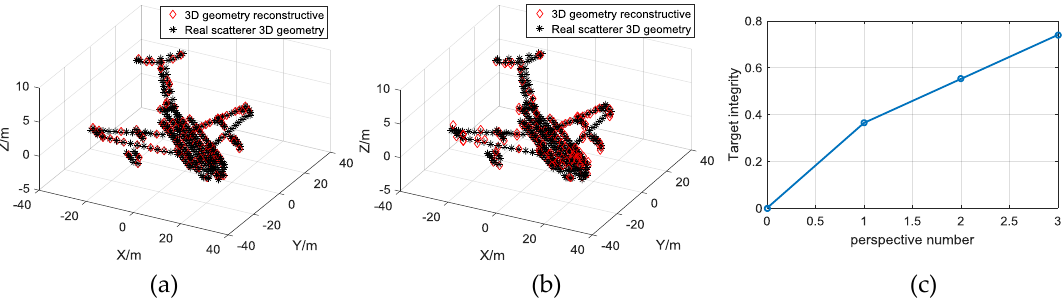
Figure 14. The estimated attitudes of multi-perspective 3D reconstruction from di ff erent conditions. ( a ) The estimated attitudes of multi-perspective when the rotational velocity is 2 degrees per second and noise level is 0.5 times range resolution. ( b ) The estimated attitudes of multi-perspective when the rotational velocity is 10 degrees per second and noise level is 5 times range resolution. ( c ) The integrity of multi-perspective 3D reconstruction varies with the number of utilized